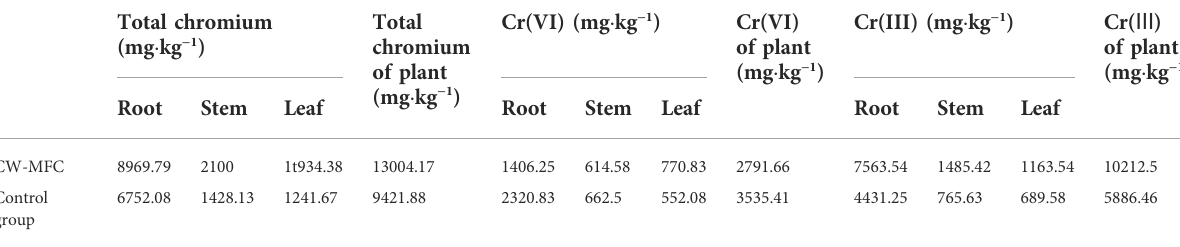
TABLE 1 Cr concentrations in the plants.